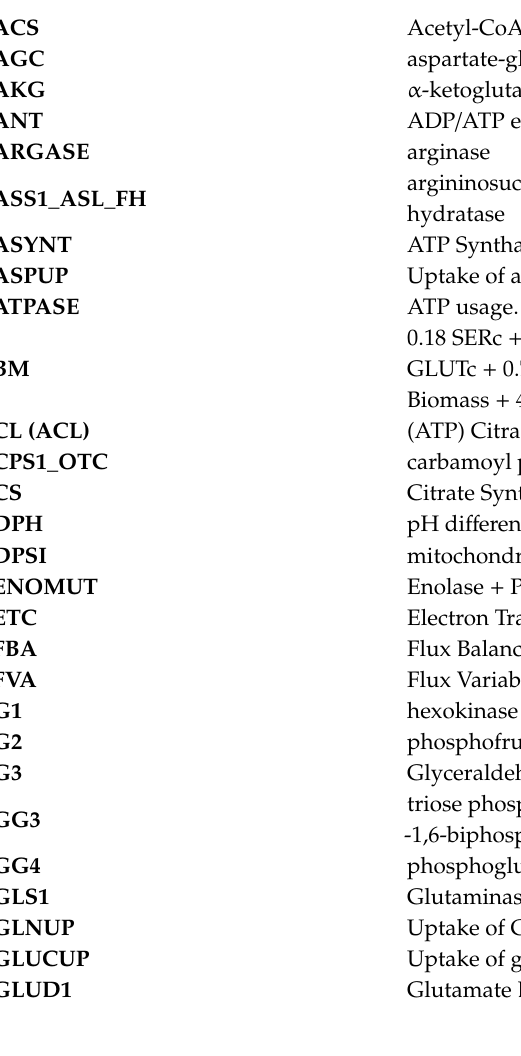
glucose, Figure S3: The complete C2M2N metabolic network of pyruvate synthesis from glutamine and glucose, Figure S4: The complete C2M2N metabolic network of aspartate synthesis from glutamine and glucose, Figure S5: The complete C2M2N metabolic network of nucleotides synthesis from glutamine and glucose, Figure S6: The complete C2M2N metabolic network of Fatty Acids synthesis from glutamine and glucose, Figure S7: The complete C2M2N metabolic network of serine synthesis from glutamine and glucose, Figure S8: The complete C2M2N metabolic network of biomass production (BM = 1) with various amount of glutamine and glucose together, Figure S9: The complete C2M2N metabolic network of high biomass production (BM = 3) with various amount of glutamine and glucose